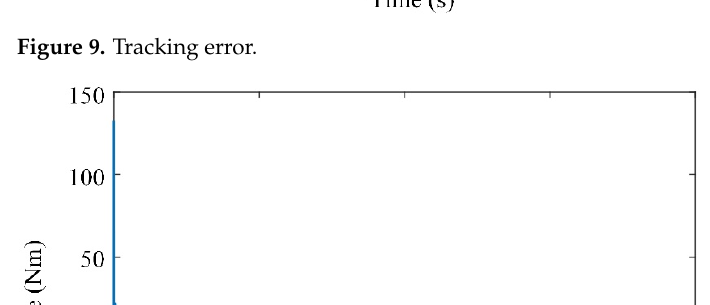
Figure 9. Tracking error.